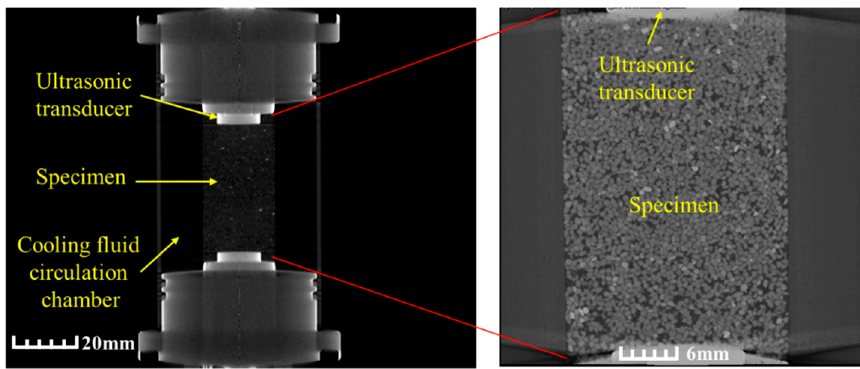
Figure 7. The overall schematic of a specimen scan.